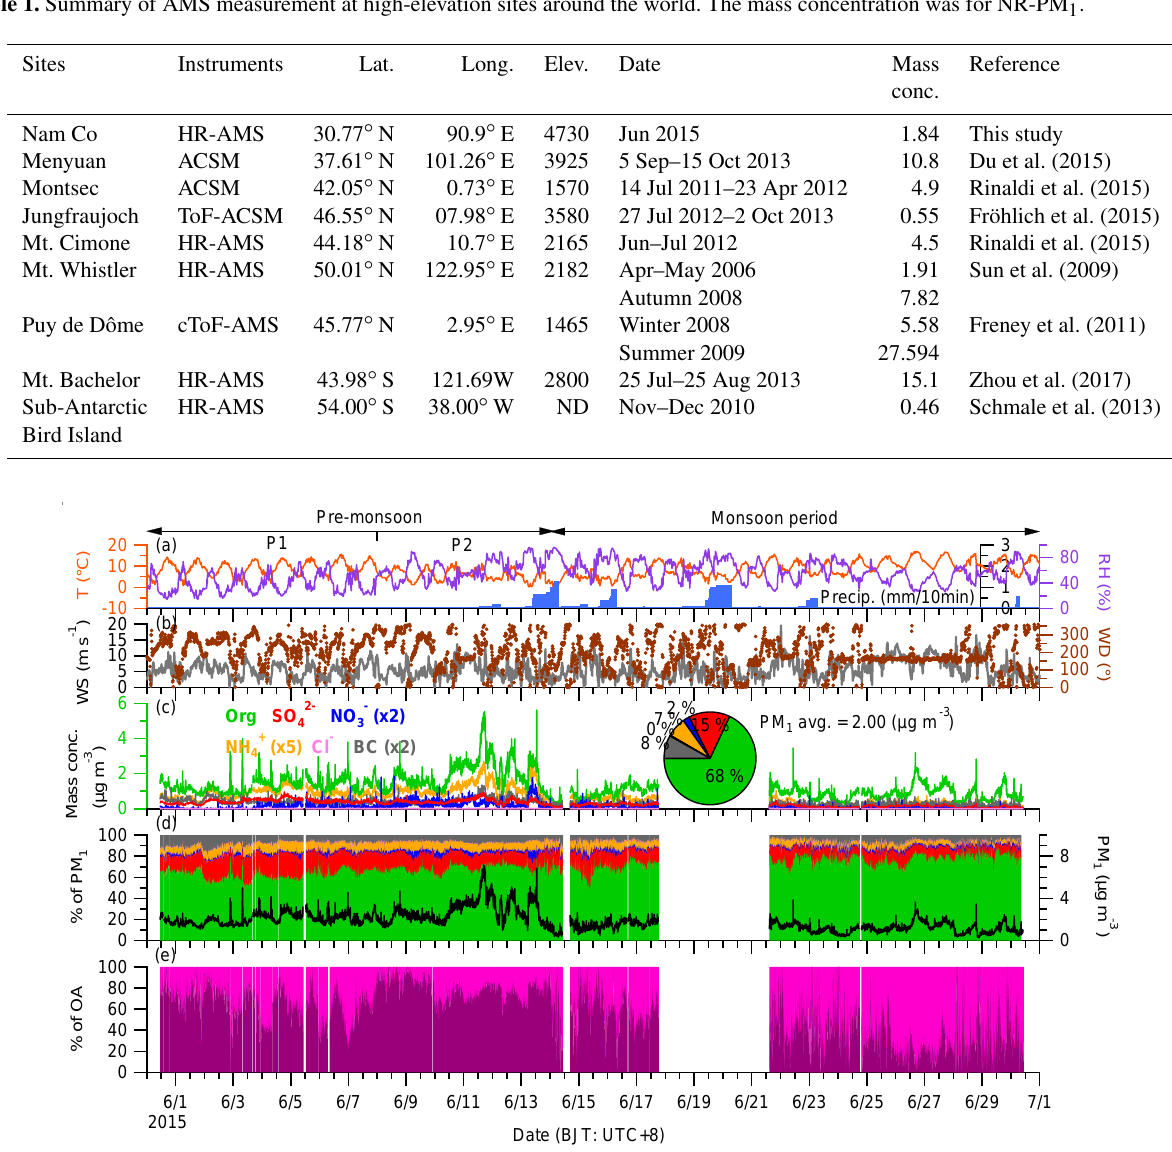
Figure 2. The combo plot of the data of the Nam Co study including (a) the meteorological conditions ( T : air temperature; RH: relative humidity; Precip.: precipitation), (b) the variation of WS (wind speed) colored according to WD (wind direction), (c) the temporal variation of mass concentration of PM 1 species and the average contribution each species (pie chart), (d) the mass contribution of each PM 1 species and the total mass concentration of PM 1 , and (e) the mass contribution of PMF results (Sect. 3.5). Three periods based on the meteorological conditions were marked. Please note the dates are given in MM/DD